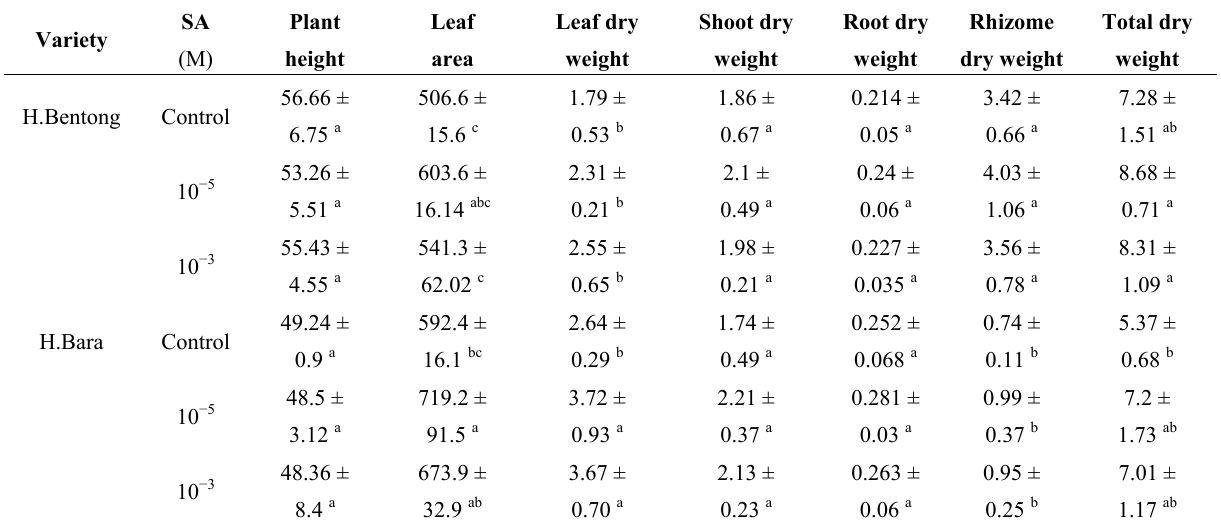
Table 1. Effect of foliar SA application (10 − 3 and 10 − 5 M) on plant height, leaf area and dry weight of ginger